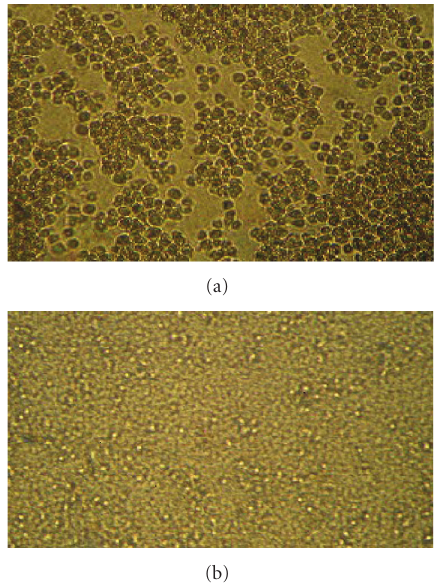
Figure 2: (a) Tumor cell after 72h without Pd(C 19 H 20 N 4 O 3 )Cl 2 compound. (b) tumor cell after 72h with Pd(C 19 H 20 N 4 O 3 )Cl 2